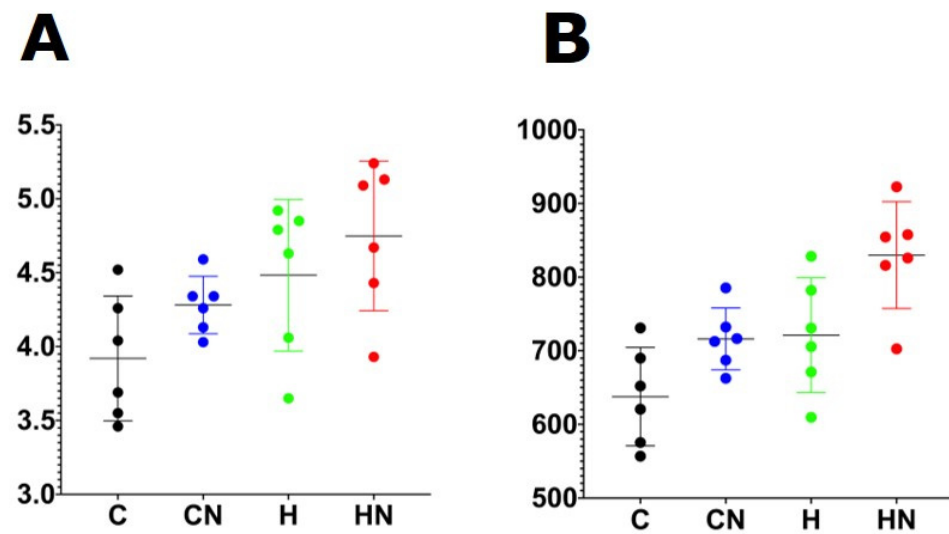
Figure 3. ( A ) Shannon diversity and ( B ) richness of faecal samples. C, rats fed with corn starch diet; CN, rats fed with corn starch diet + Nannochloropsis oceanica ; H, rats fed with high-carbohydrate, high-fat diet; HN, rats fed with high-carbohydrate, high-fat diet + Nannochloropsis oceanica .